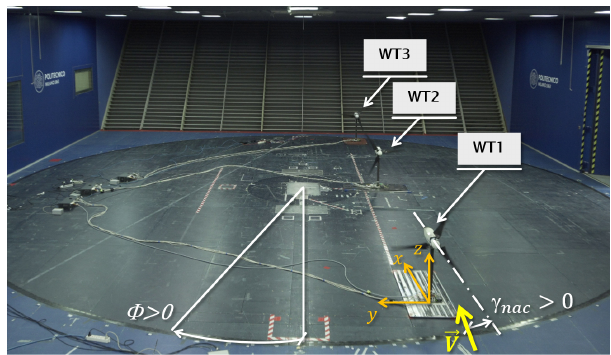
Figure 1. Experimental setup, showing the three model turbines mounted on the wind tunnel turntable. The x – y – z frame is fixed with respect to the tunnel and does not rotate with the